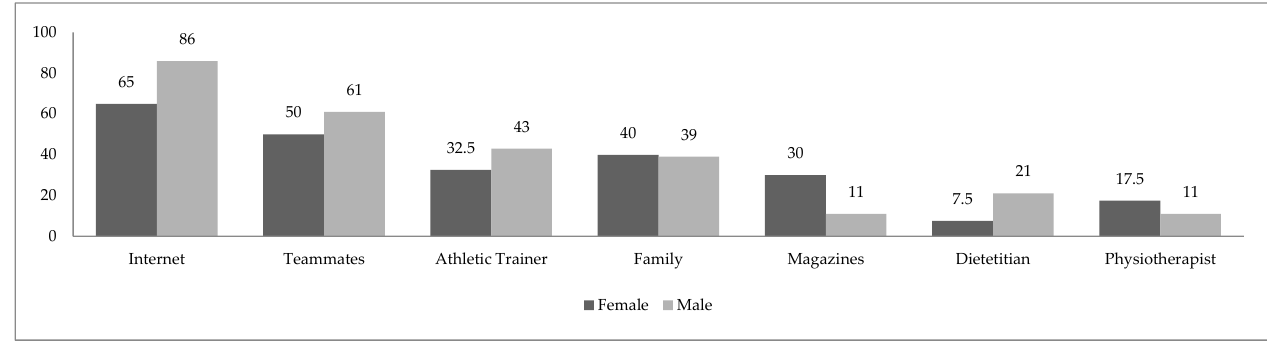
Figure 2. Comparison of most often indicated resource of dietary supplement information in female and male group, presented as proportion of each cohort (%).